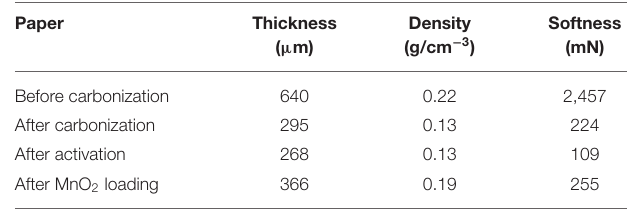
carbonization and after activation and MnO 2 loading.